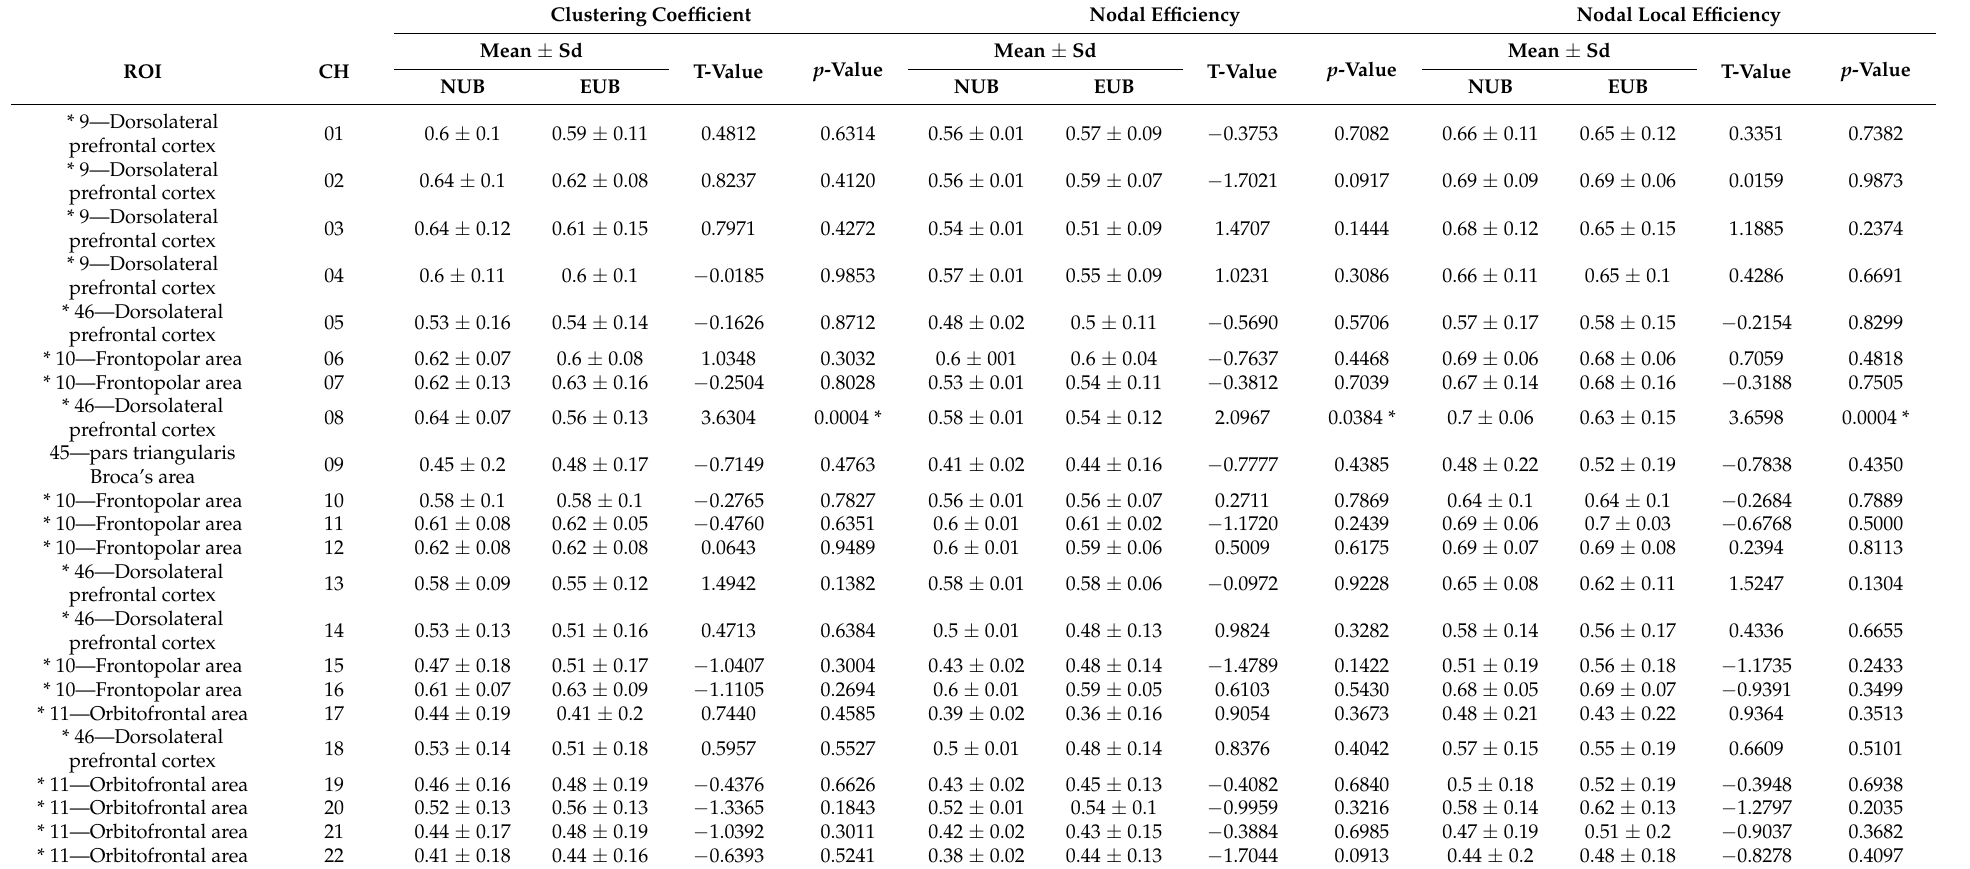
Table 4. Group differences in clustering coefficient, nodal efficiency and nodal local efficiency during resting